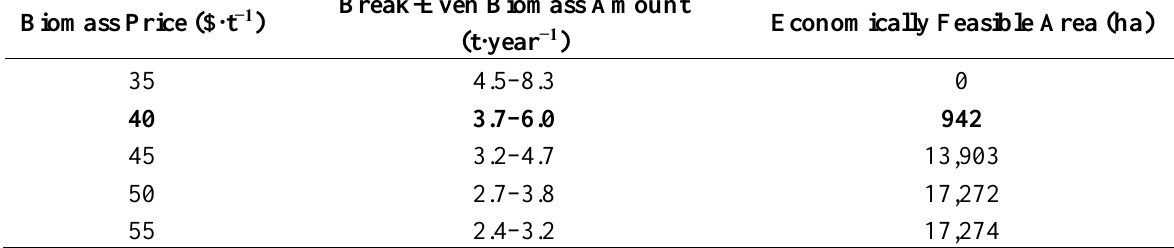
Table 2. Scenario II results: delivered biomass price sensitivity analysis and associated economically feasible area. (Bold font indicates baseline scenario).